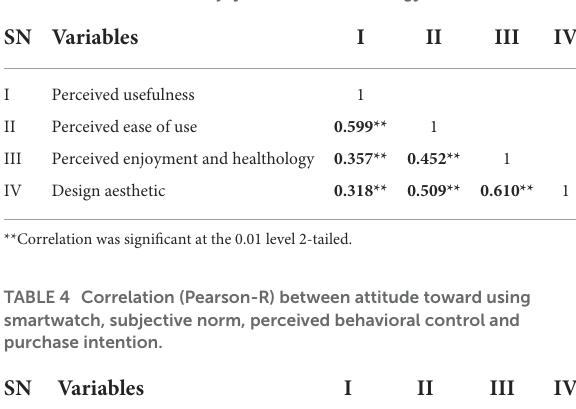
TABLE 3 Correlation (Pearson-R) between design aesthetic, perceived usefulness, ease of use, enjoyment and healthology.